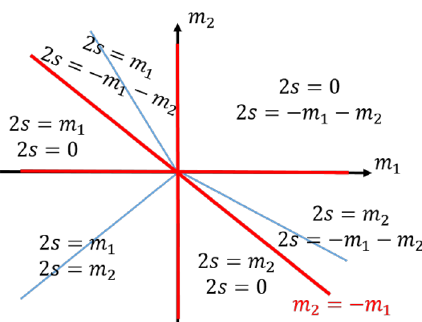
Figure 5 . Phase Diagram for the N = 2 SU(3) gauge theory. The vacua at generic points are 5 = 2 trivial theories, while blue lines indicate moduli spaces. The solutions \jump" along the red lines. The transitions along the red lines aren’t smooth, as opposed to the transitions in the dual